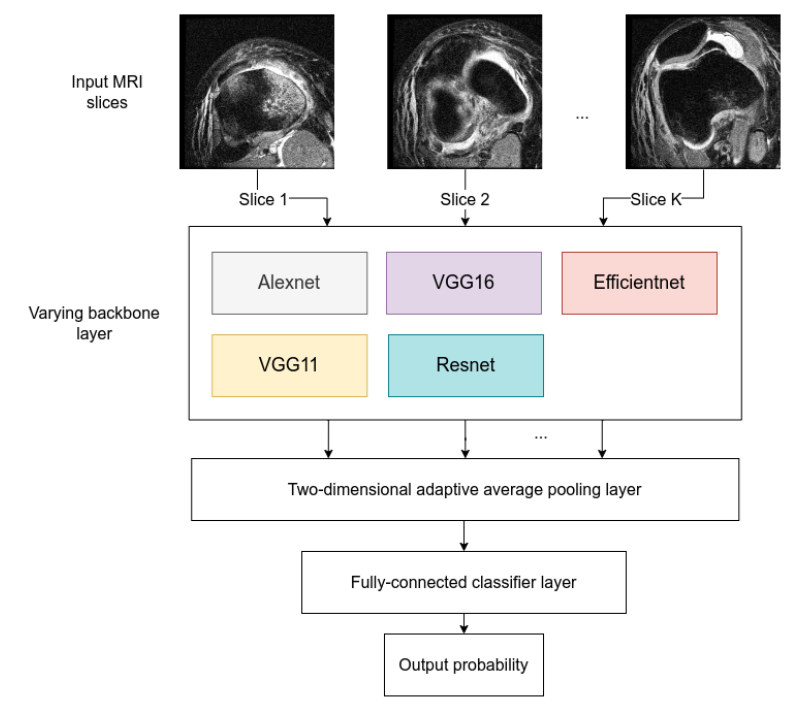
Figure 5. Adapted architecture of a single MRNet block. The input is processed by varying CV archi- tectures (backbones), and adaptive average pooling is applied to the backbone output for each MRI slice. Afterwards, a fully-connected classifier layer returns the probability for a particular